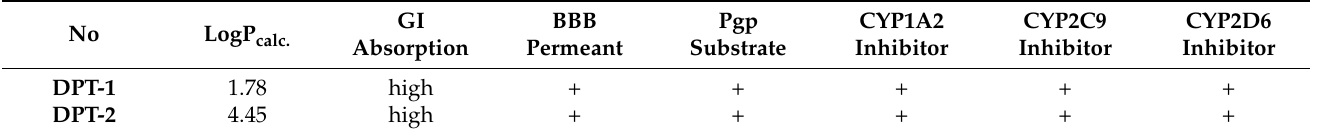
Table 3. The ADME activities predicted for DPT-1 and DPT-2 [32].